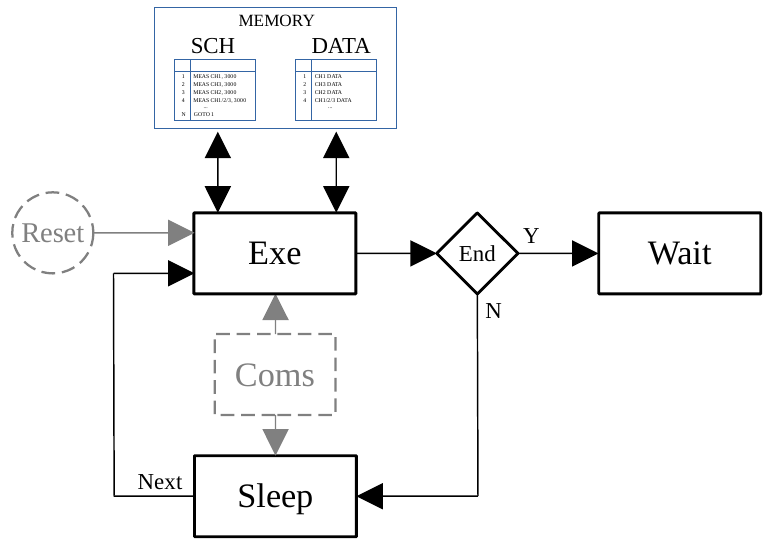
Figure 1. Basic execution scheme of a sensor